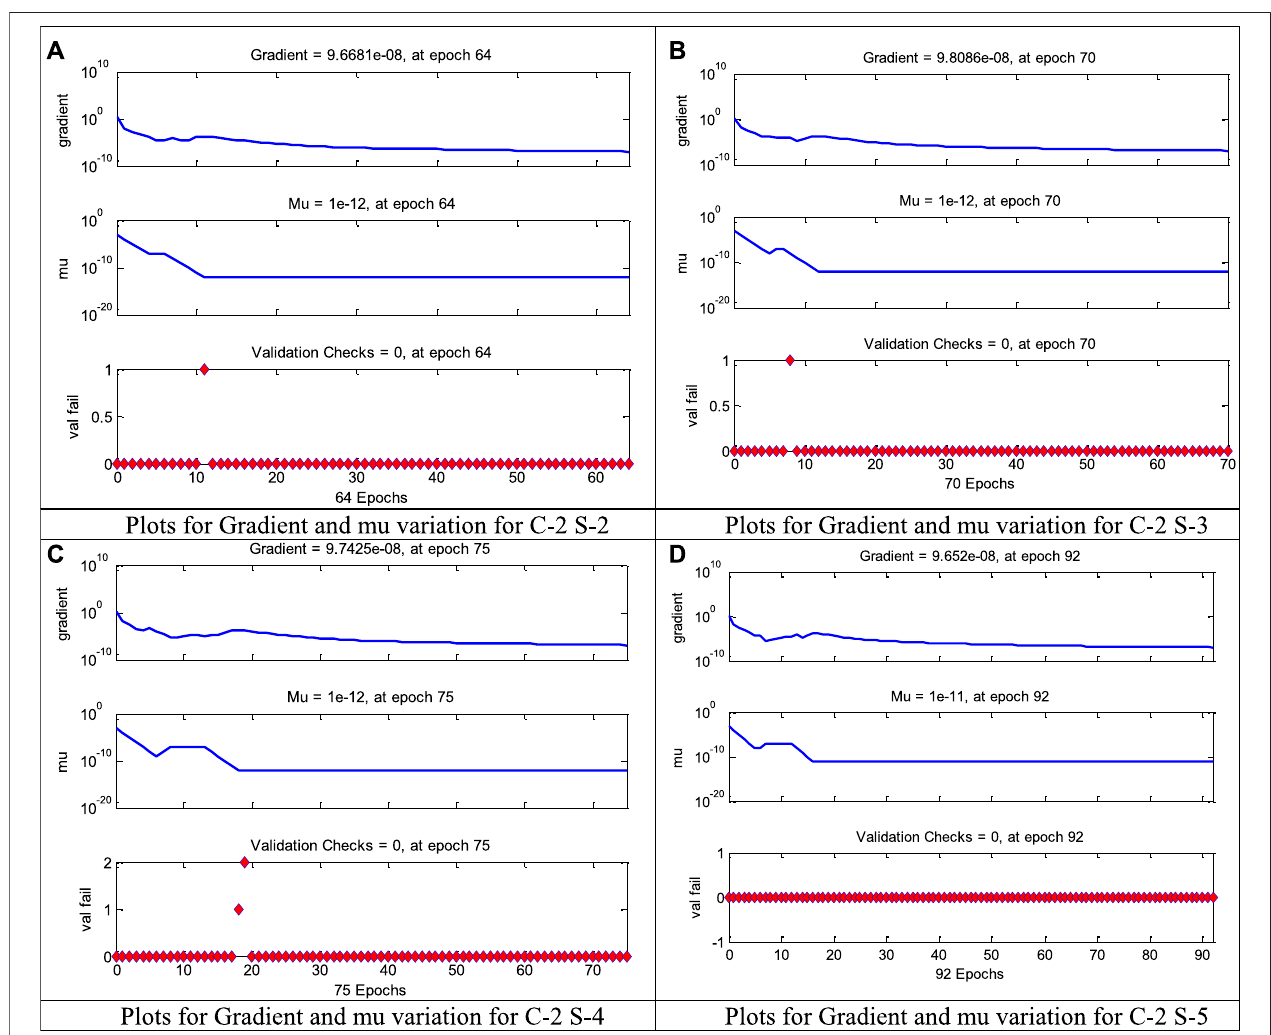
FIGURE 11 | Plot for gradient and mu of second cases of all